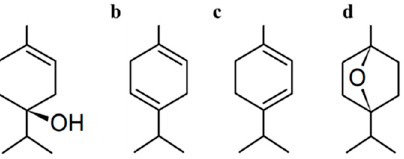
Figure 5. Major components and typical composition of M. alternifolia : ( a ) terpinen-4-ol (40%), ( b ) γ - terpinene (23%), ( c ) α -terpinene (10%), ( d ) 1,8-cineole (5%). ( b ) γ -terpinene (23%), ( c ) α -terpinene (10%), ( d ) 1,8-cineole